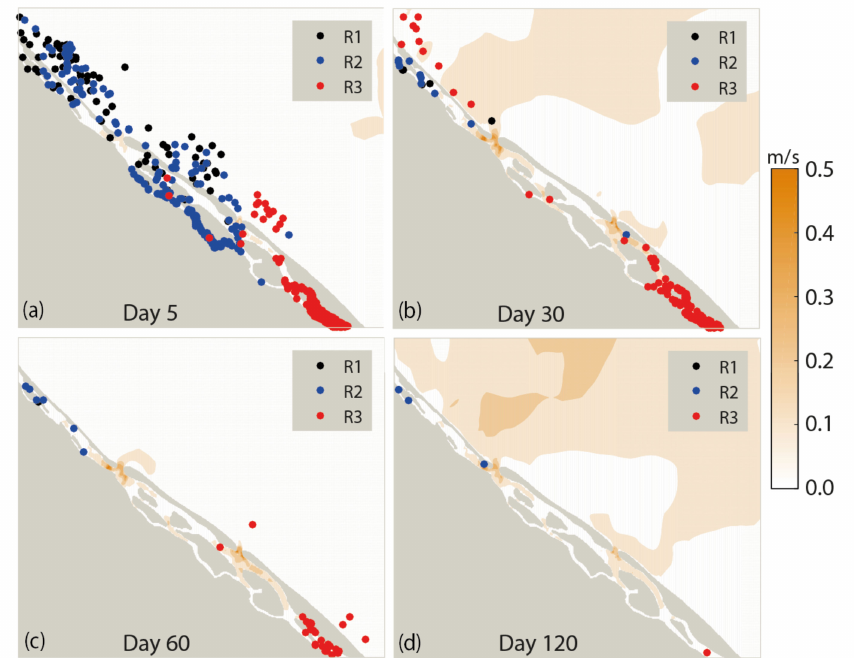
Figure 8. Spatial distributions of the current speed and trajectories for particles released at R1, R2 and R3 (please refer Figure 2 for initial release locations) on ( a ) Day 5, ( b ) Day 30, ( c ) Day 60 and ( d ) Day 120 during the northeast monsoon for both inlets configuration.